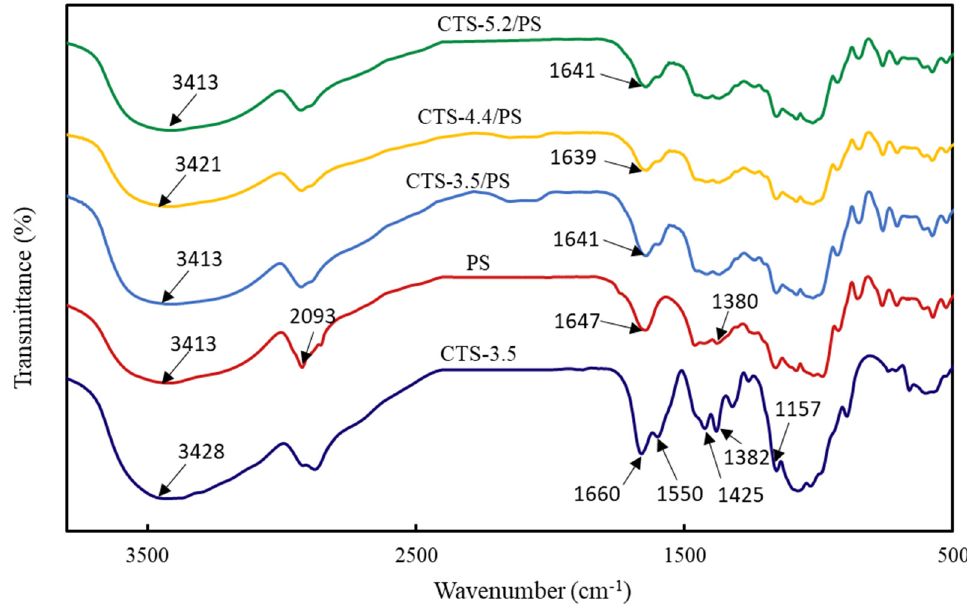
Figure 6. Infrared spectrogram of materials.